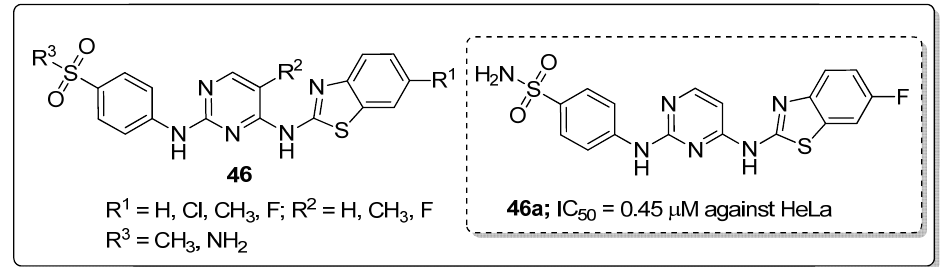
Figure 53. Anticancer activity of the most active pyrimidine-benzothiazole hybrid 46a .